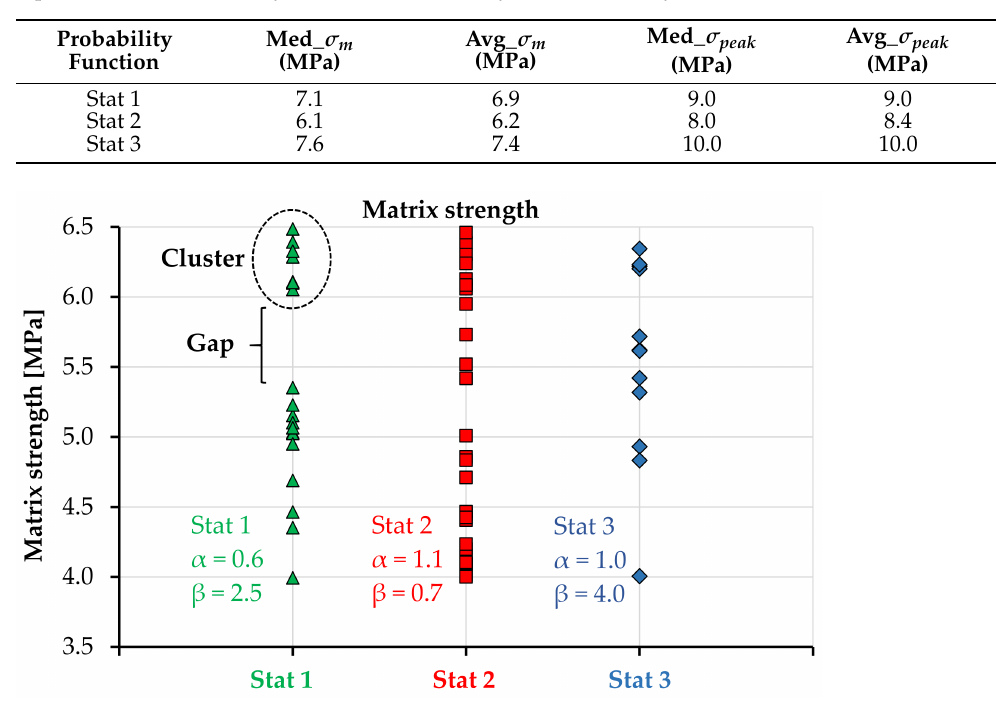
Table 4. Median and average values of matrix strength and tensile strength over the elements in an SHCC model specimen depending on the Weibull distribution function. These values are only representative for the arrays of the numbers analyzed in this study.